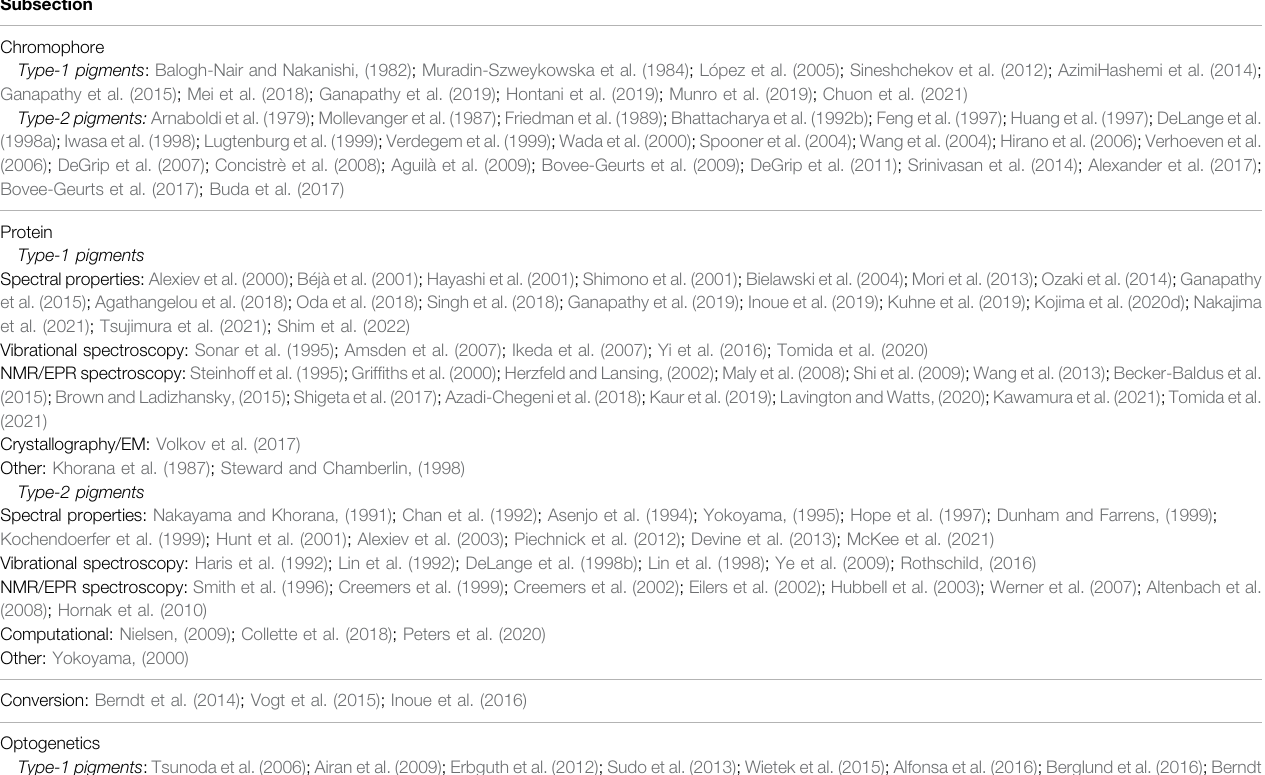
TABLE 5 | Selected additional citations for the section “ Bioengineering ”